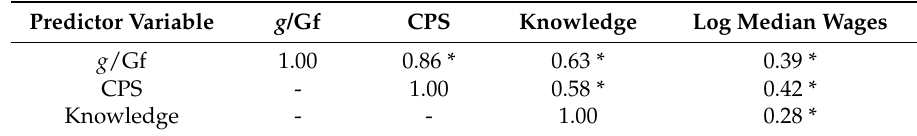
Table 2. Correlations among the skills variables and occupation log income. Predictor Variable g /Gf CPS Knowledge